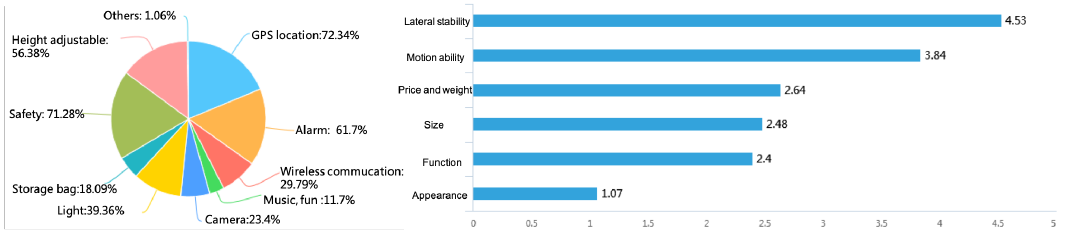
Figure 2. Demand analysis of Kano attribute